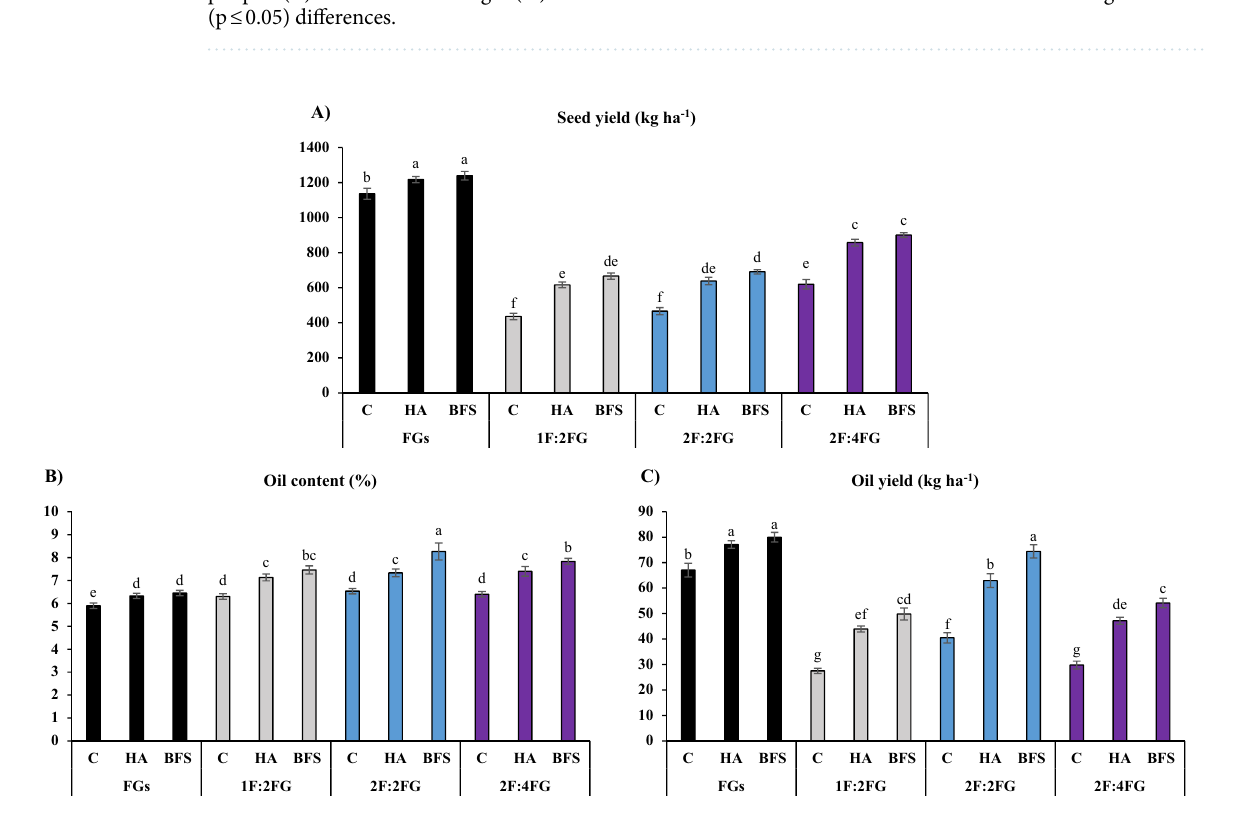
Figure 6. Means comparison for the interaction effects of fertilization [C (control), HA (humic acid), BFS (biofertilizers)] and different cropping patterns [FGs (fenugreek sole cropping), 1F:2FG, 2F:2FG, 2F:4FG (ratios of fennel and fenugreek in the intercropping patterns)] on seed yield ( A ), oil content ( B ), and oil yield ( C ) of fenugreek. Different lower-case letters above the bars indicate significant (p ≤ 0.05)